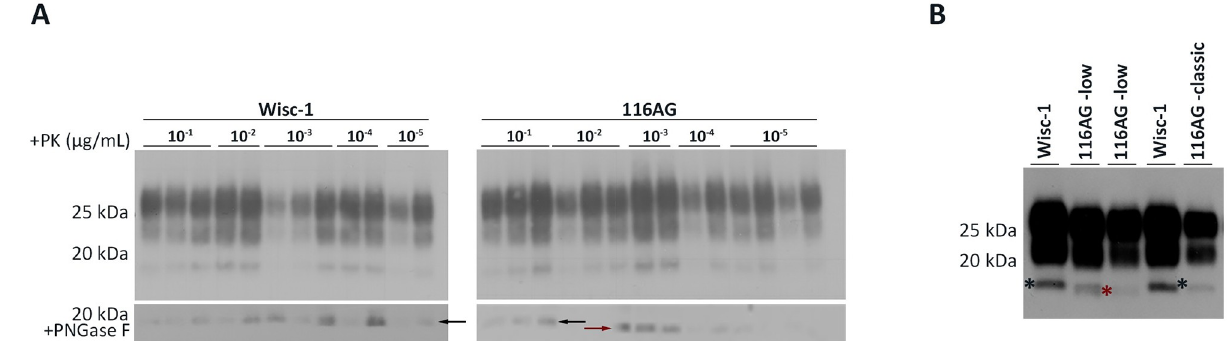
Fig 6. Different migration patterns of unglycosylated PrP res are associated with 116AG prions. (A) Western blot of tg1536 +/+ mice intracerebrally inoculated with 10fold serial dilutions of Wisc-1 reveals indistinguishable banding pattern either with (A; lower left panel) or without (A; upper left panel) PNGase F treatment after PK digestion, using 4H11 mAb. 116AG inoculated tg1536 +/+ mice reveal a difference in the electrophoretic mobility (classic or low) in some samples after treatment with PNGase F and PK digestion (A; lower right panel). (B) The western blot depicts the different migration patterns of Syrian golden hamsters inoculated with Wisc-1 or 116AG prions, using 3F4 anti-PrP mAb. While Wisc-1 inoculated SGH always harbours the classic profile, 116AG inoculated animals show either the classic or the low migration. The asterisks/arrows show the migration profile, slow (black) and rapid (red), of the non-glycosylated